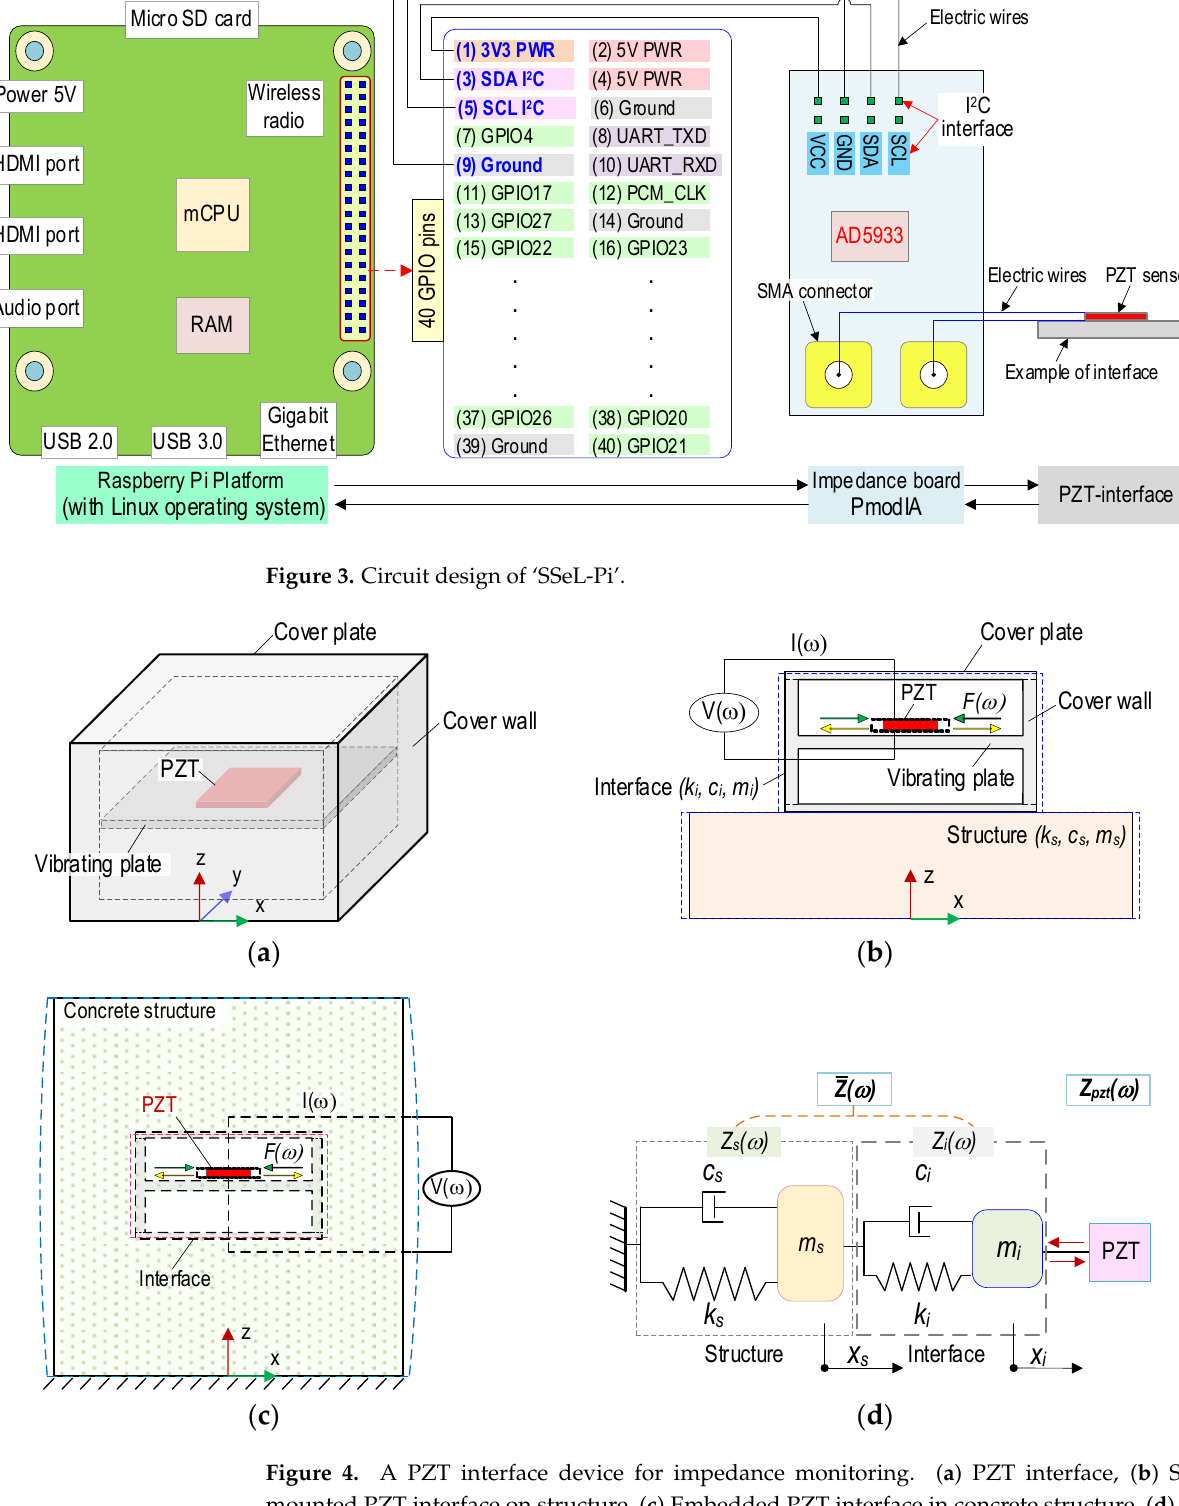
Figure 4. A PZT interface device for impedance monitoring. ( a ) PZT interface, ( b ) Surface-mounted PZT interface on structure, ( c ) Embedded PZT interface in concrete structure, ( d ) 2-DOF impedance model.